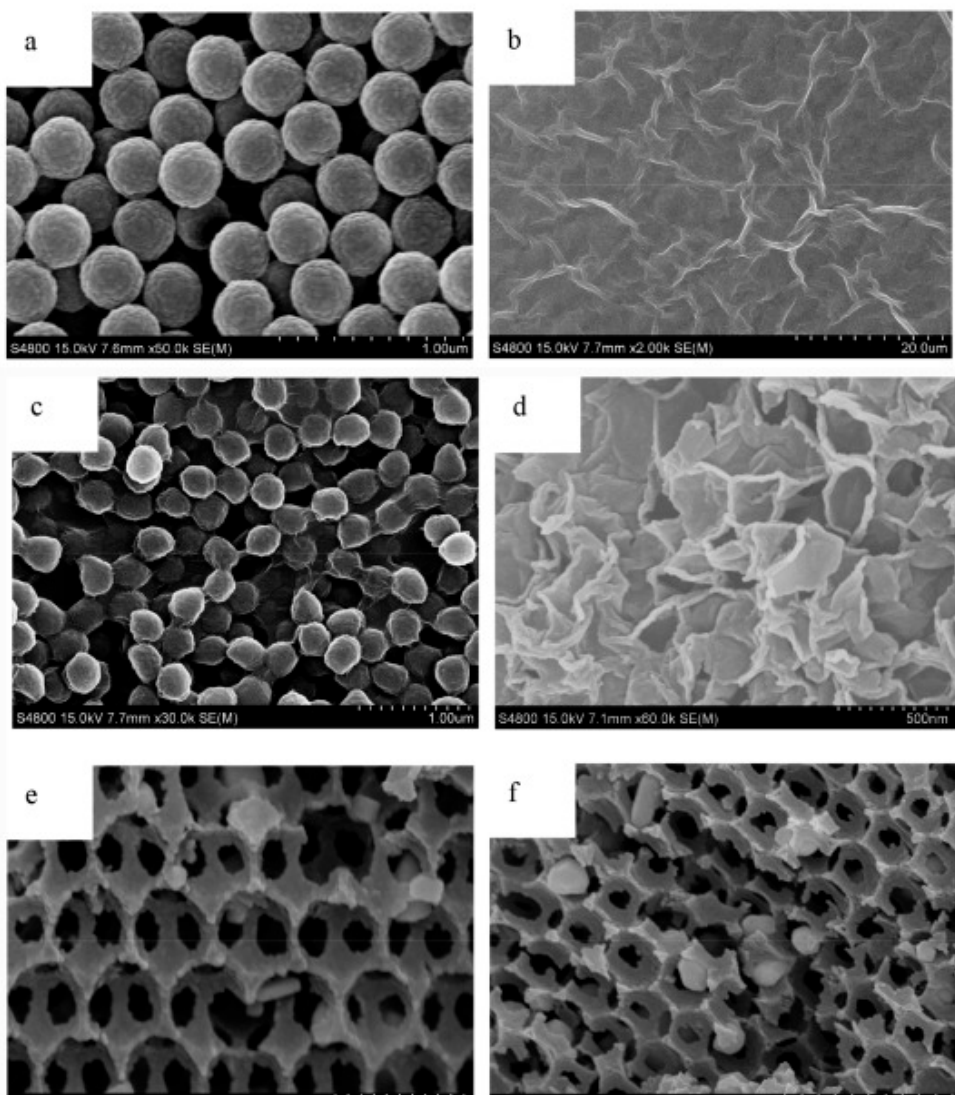
Figure 12. SEM images of ( a ) PMMA microspheres, ( b ) GO-COOH nanosheets, ( c ) PMMA/GO- COOH microspheres assembled through electrostatic interactions, ( d ) porous graphene with nickel nanoparticles-curved layers stack together forming voids ( e , f ) 3DHPG-Ni-7.5 nanocomposite-graphene network with pores after pyrolysis. Reproduced with permission from Liu et al., International Journal of Hydrogen Energy; published by Elsevier 2018.